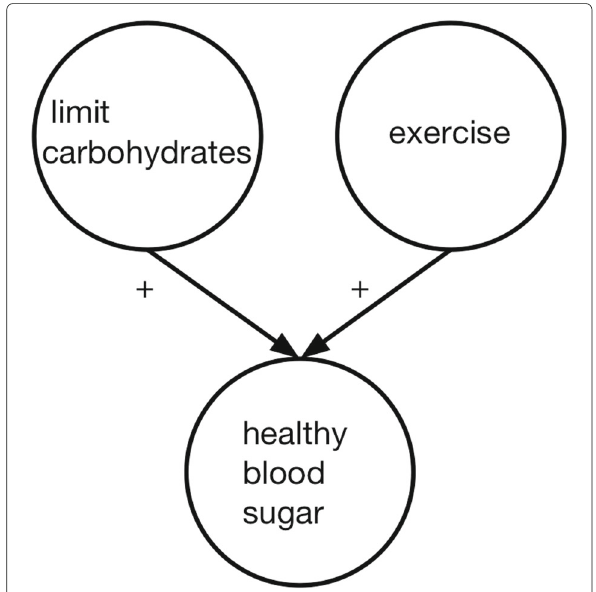
Fig. 3 Experiment 2 causal diagram